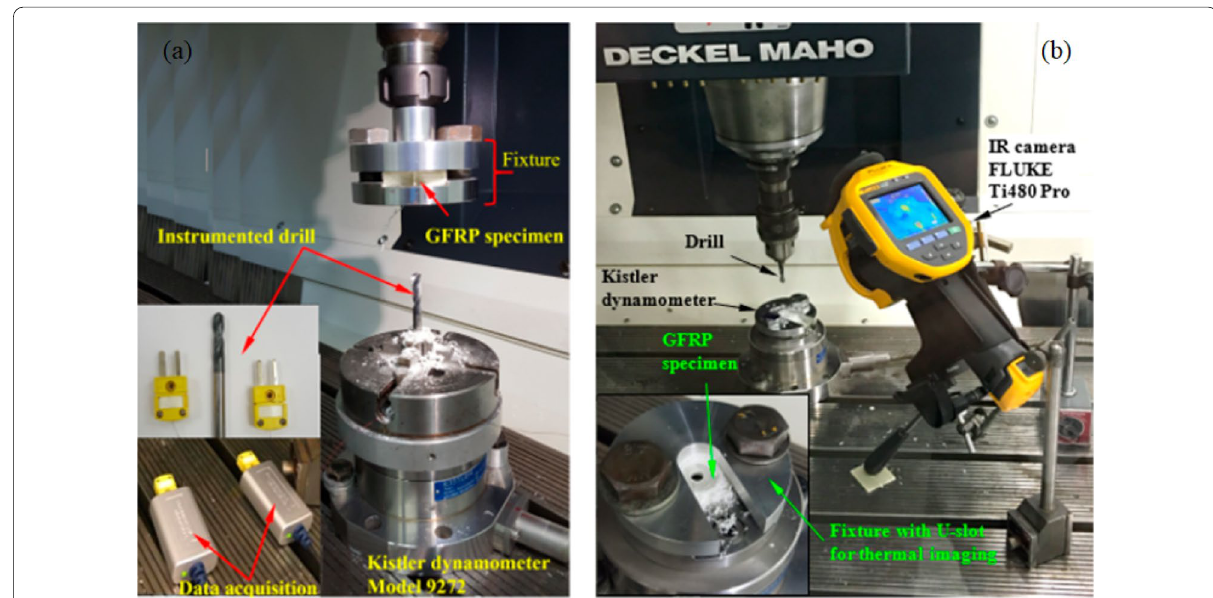
Figure 12 The temperature was measured by: a Instrumented drill with two thermocouples and b IR camera